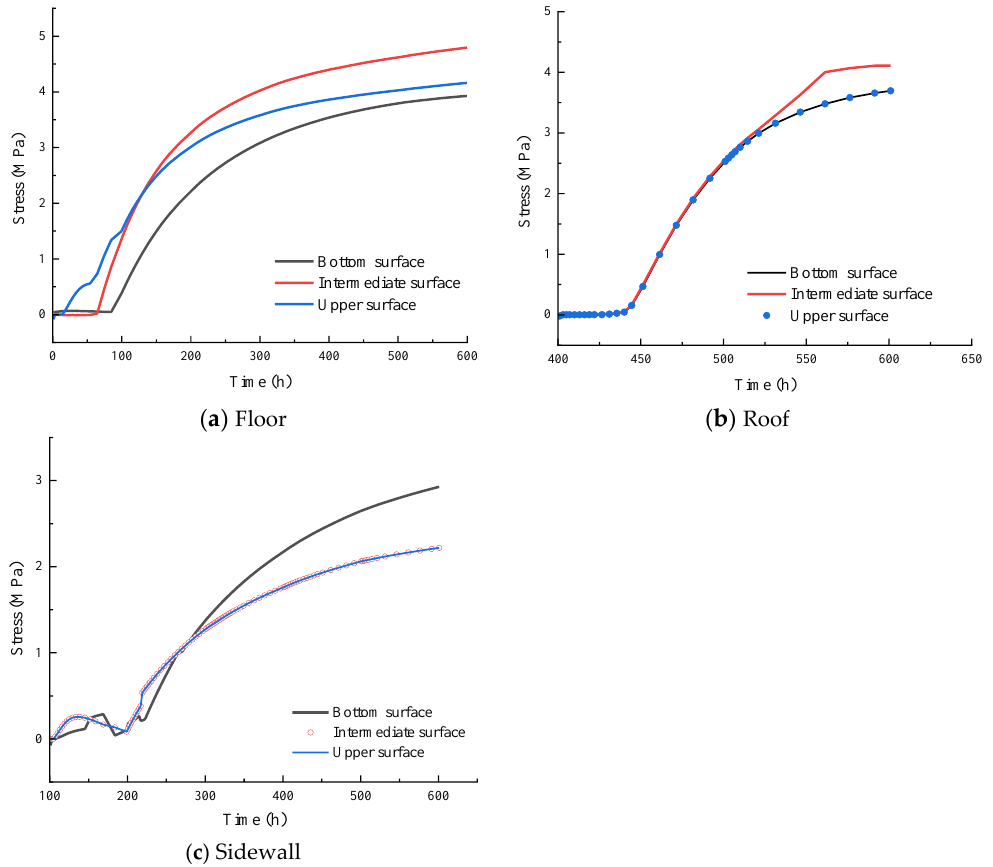
Figure 7. Maximum principal stress of a concrete structure in a metro station varies with time. As can be seen from Figure 7, the temperature stress of the side wall is smaller than that of the bottom plate and top plate; the middle position of the inside side wall is compressed, the upper and lower sides are tensioned, and the stress at the bottom of the side wall is more significant than that at the top due to the gradient effect of earth pressure. As seen in Figure 7, the temperature stress is very low in the early stage and increases more slowly on the floor and roof.